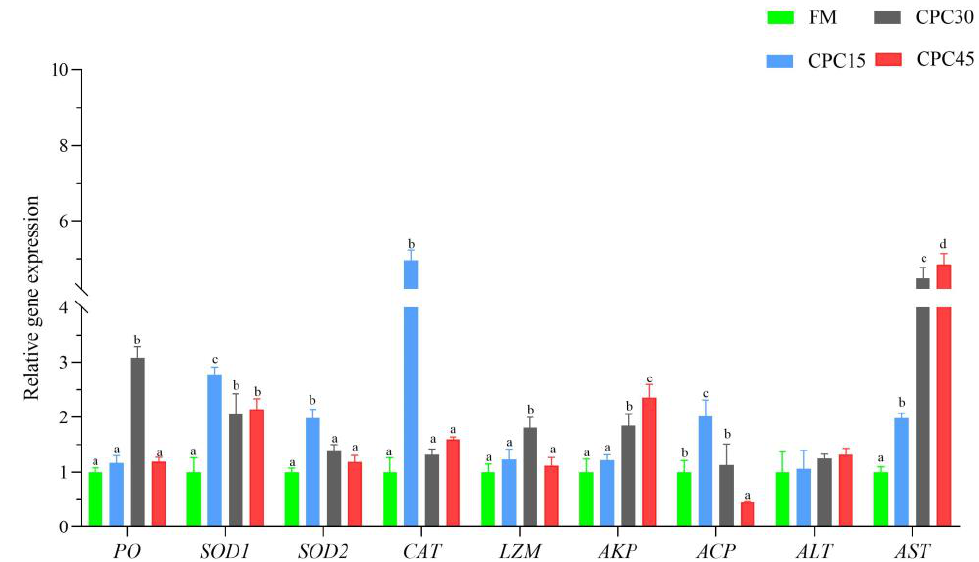
Figure 1. The expression of immune genes in the hemocytes of L. vannamei fed with increasing levels of CPC. Different superscript letters indicate significant differences exist among treatments ( p <